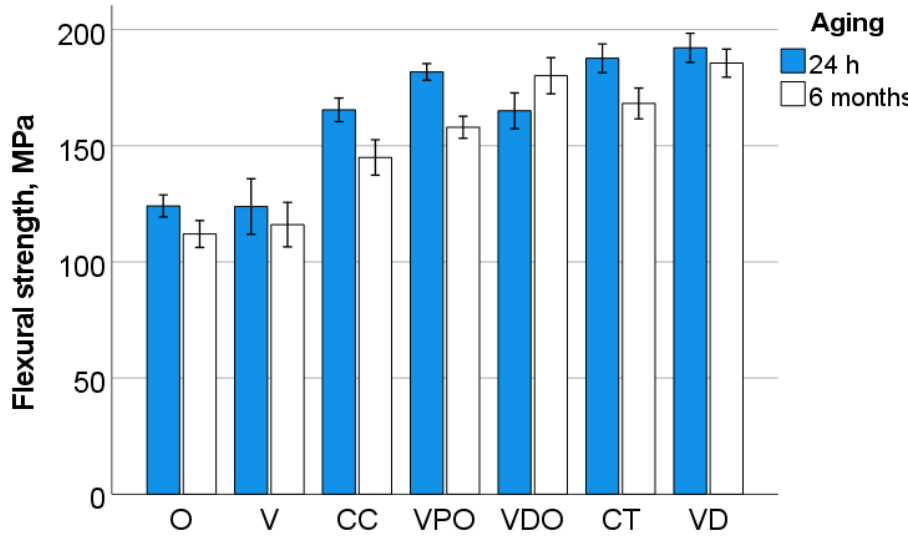
Figure 1. Flexural strength as a function of RBC and aging (mean values with 95% confidence interval).